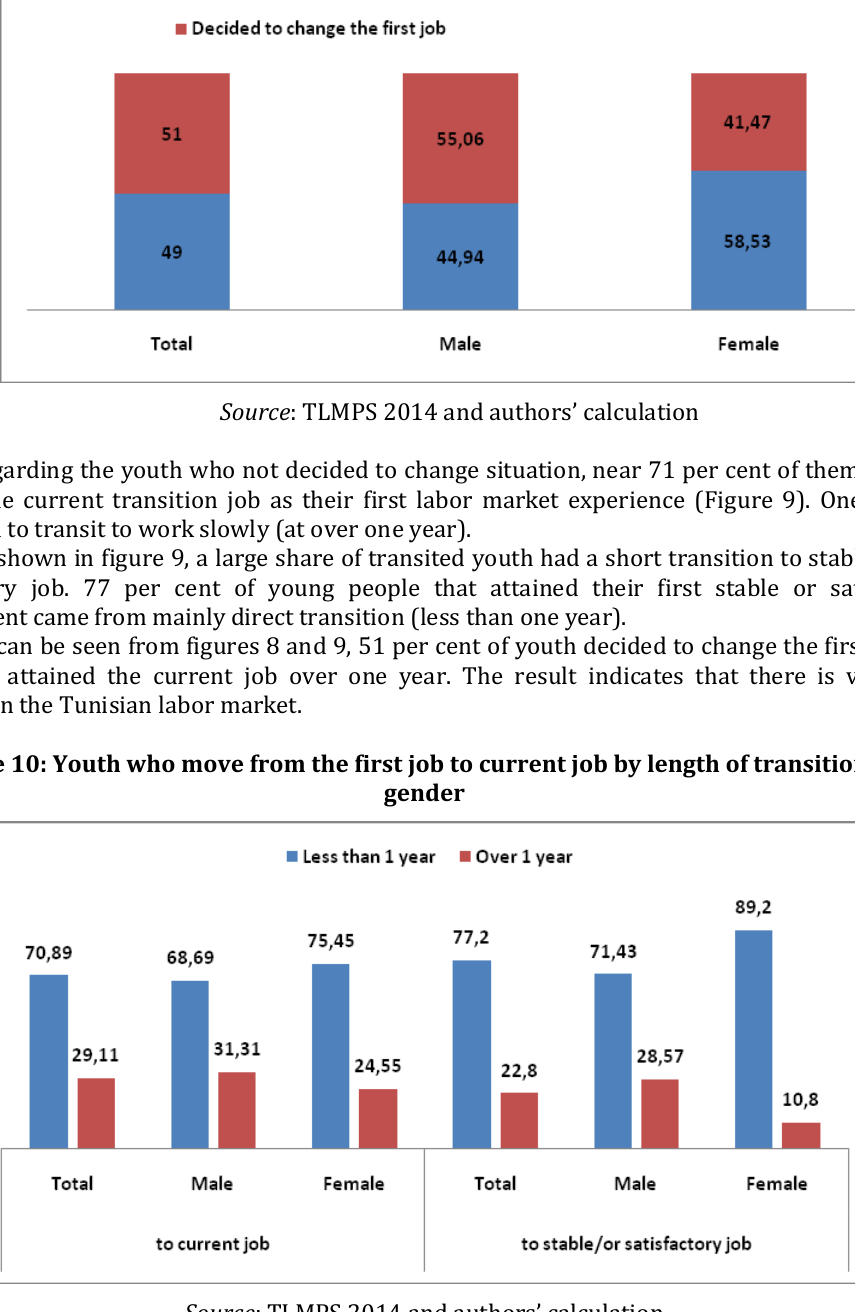
Source : TLMPS 2014 and authors’